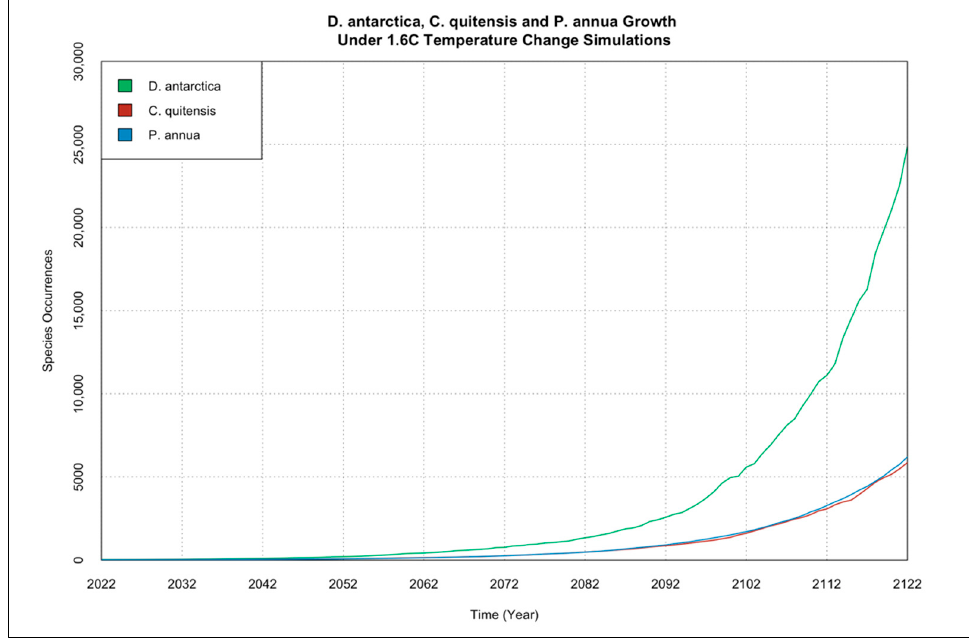
Figure 7. D. antarctica, C. quitensis and P. annua Occurrences under No Temperature Change Simu- lation.